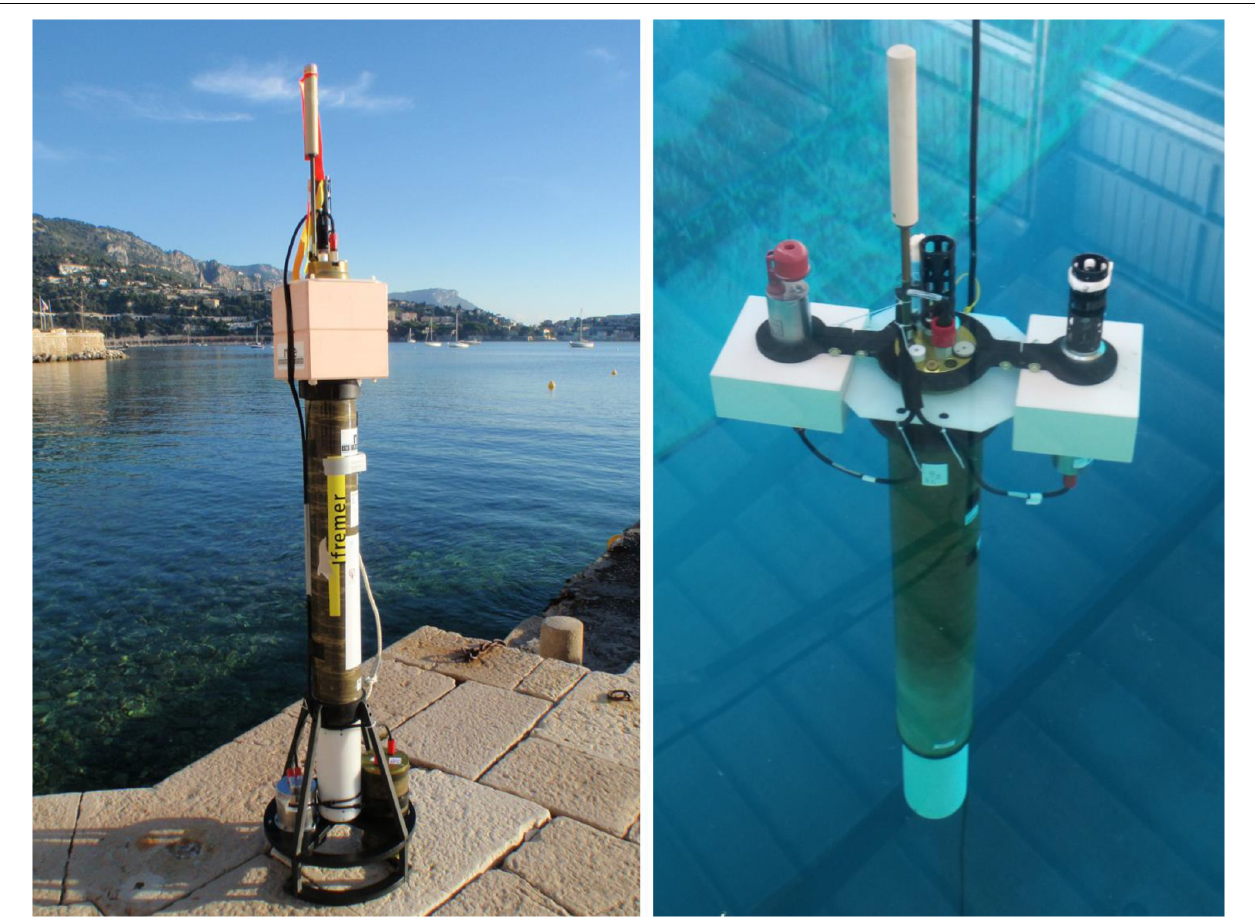
FIGURE 3 | Left : Wapiti Deep-Arvor equipped with an ADCP operating in altimetry and bottom-tracking modes. Right : 3-headed Deep-Arvor platform designed to compare the CTD performance of SBE41CP, SBE61CP and RBRconcerto 3 in situ . Courtesy of